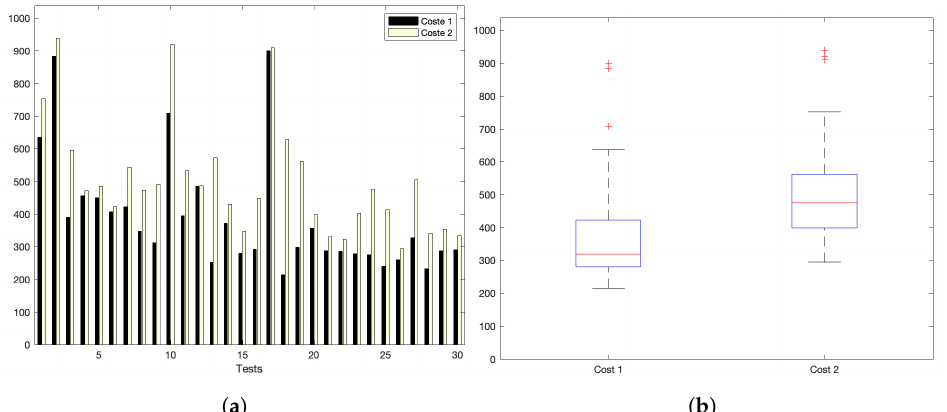
Figure 11. Med-low request burst-rate. ( a ) Individual test values for cost 1 and cost 2 . ( b ) Summary values.